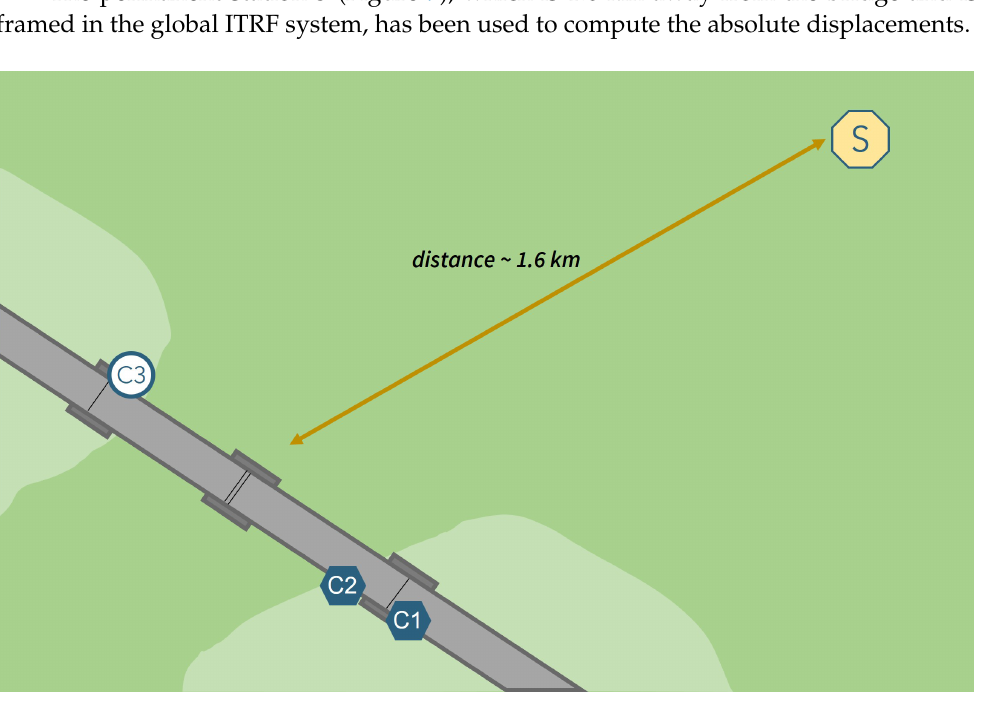
Figure 9. Conceptual scheme showing the position of permanent station S with respect to the monitoring network on the bridge. The aspect ratio is not maintained.